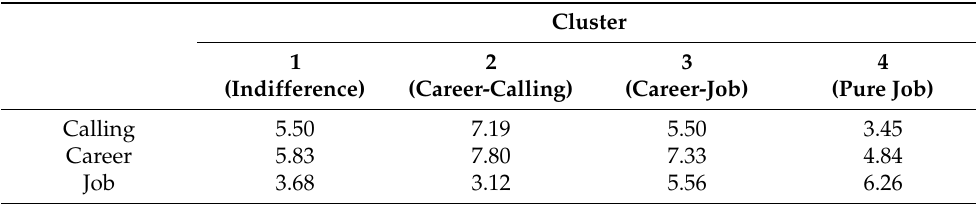
Table 2. Cluster analysis and explained variance of each of the